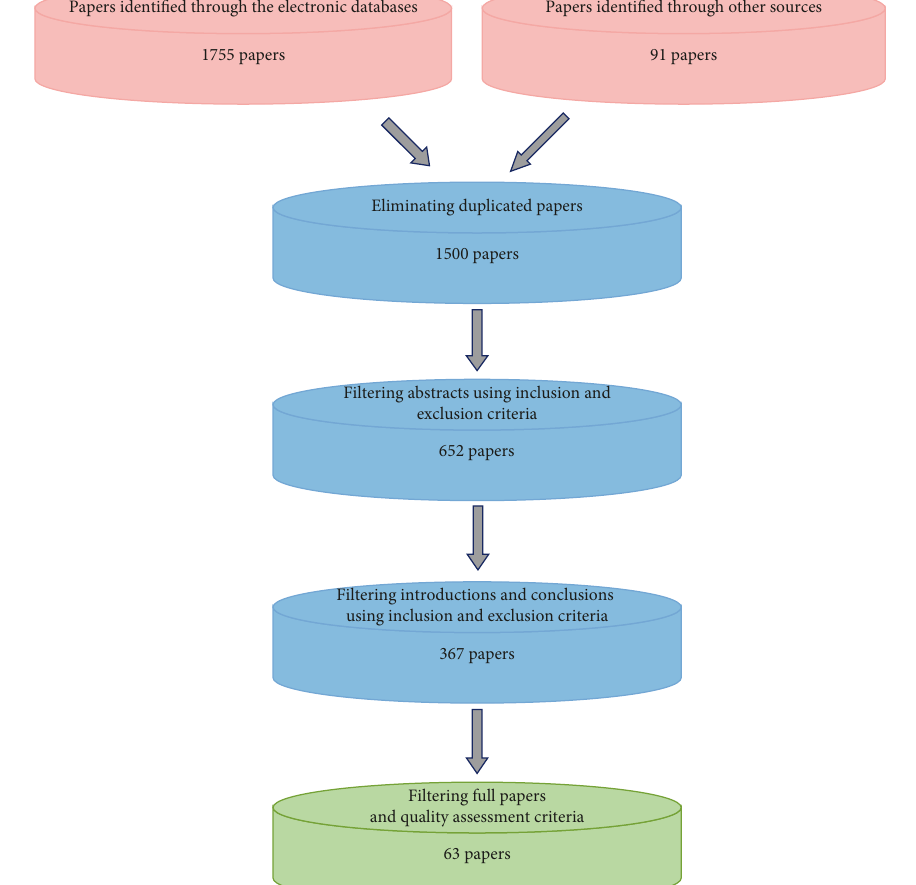
Figure 3: Selection procedure of